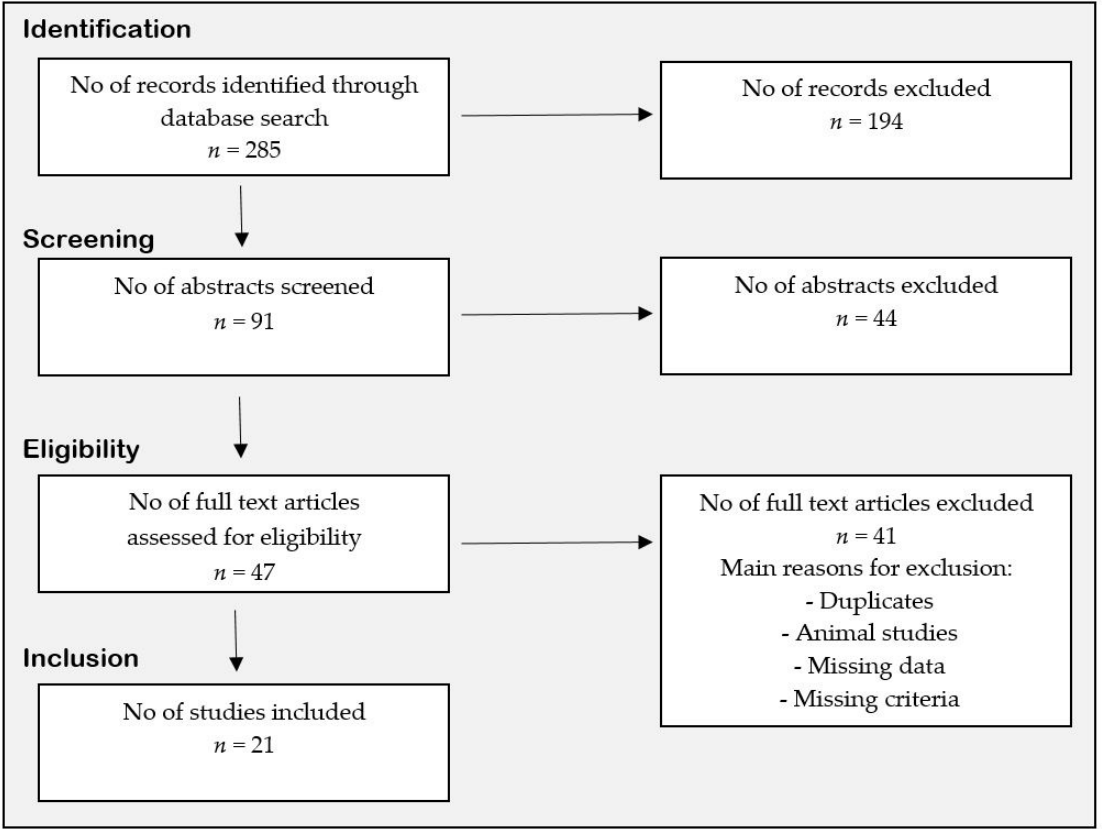
Figure 1. Flow diagram of the review process.